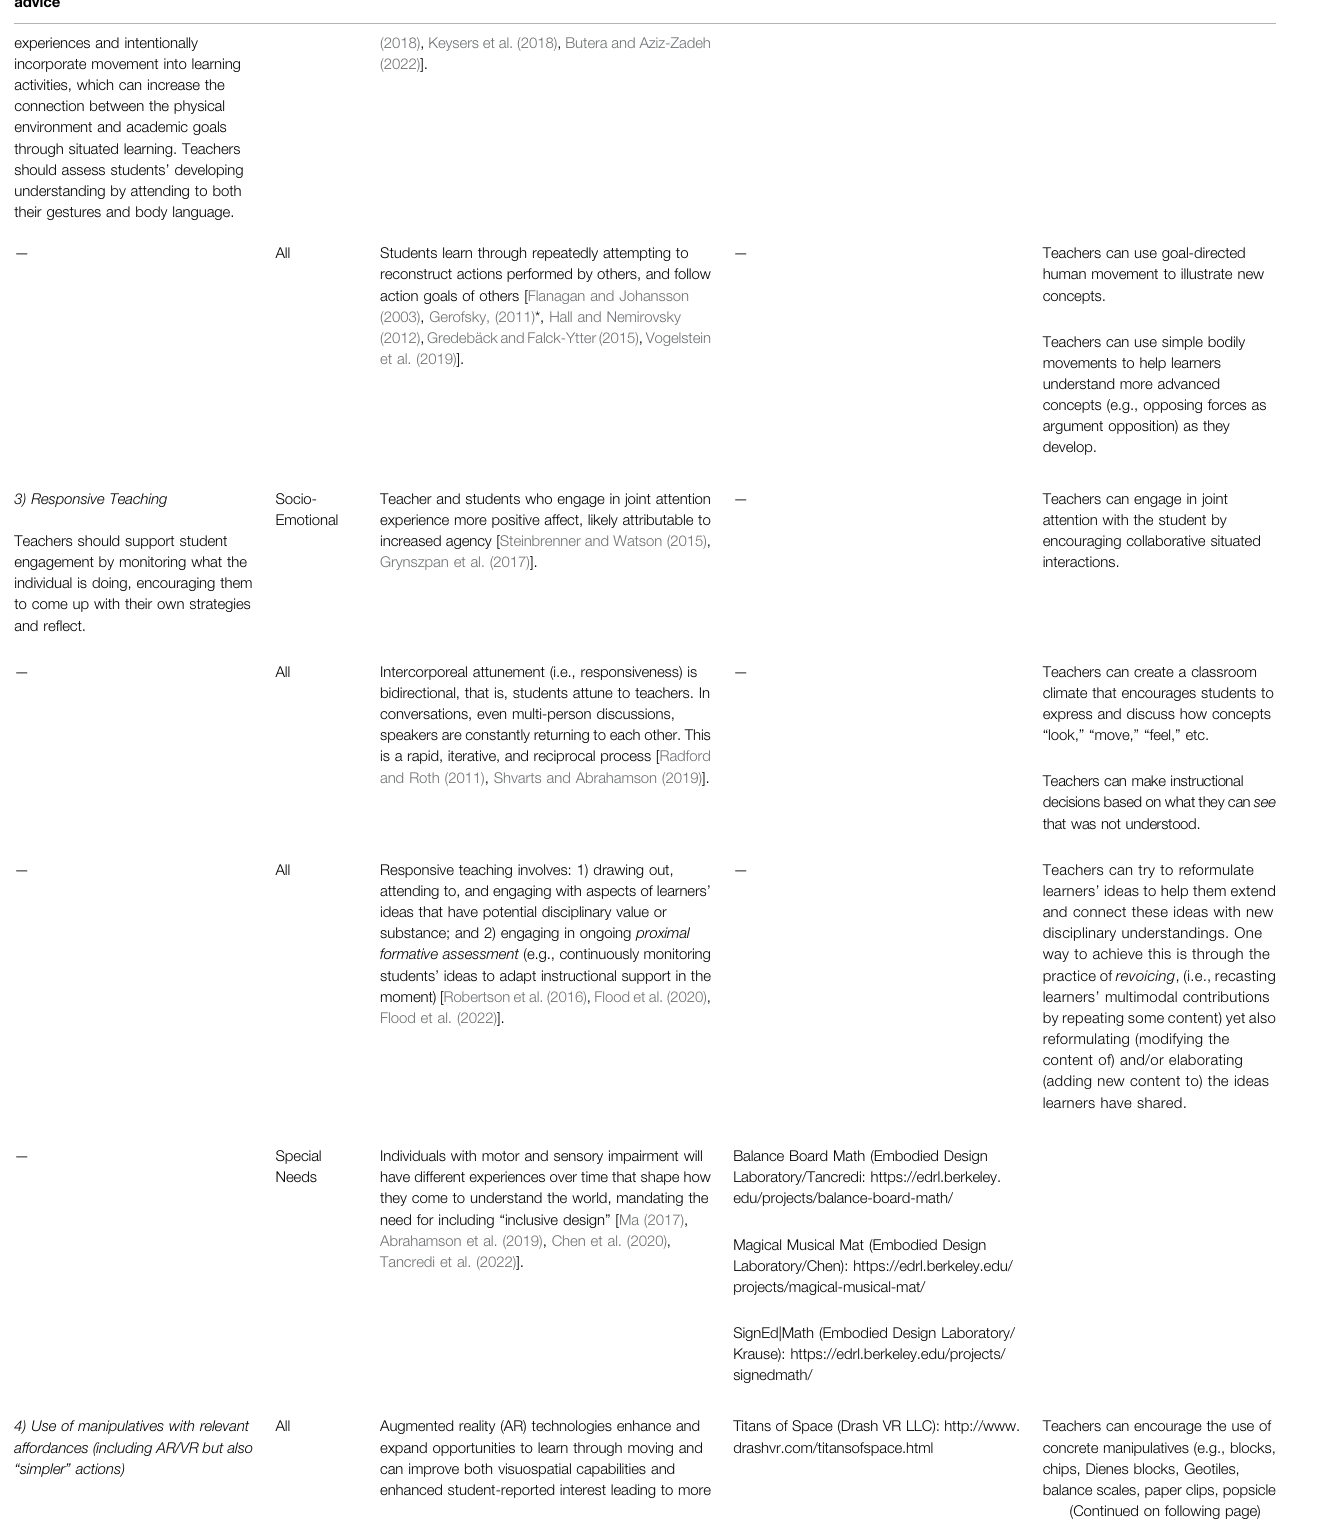
TABLE 1 | ( Continued ) Key Principles for Translational Learning Sciences Research for Embodied Cognition and Embodied Learning. EC principle and generalized